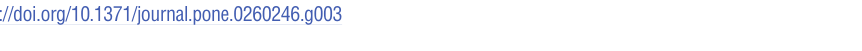
PLOS ONE | https://doi.org/10.1371/journal.pone.0260246 December10,